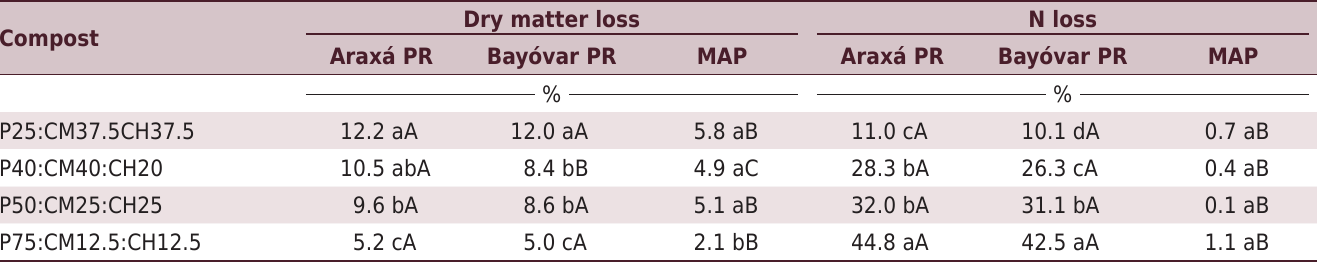
Means followed by the same letter, lowercase for compost (column) and uppercase for P source (row), are not statistically different by the Tukey test